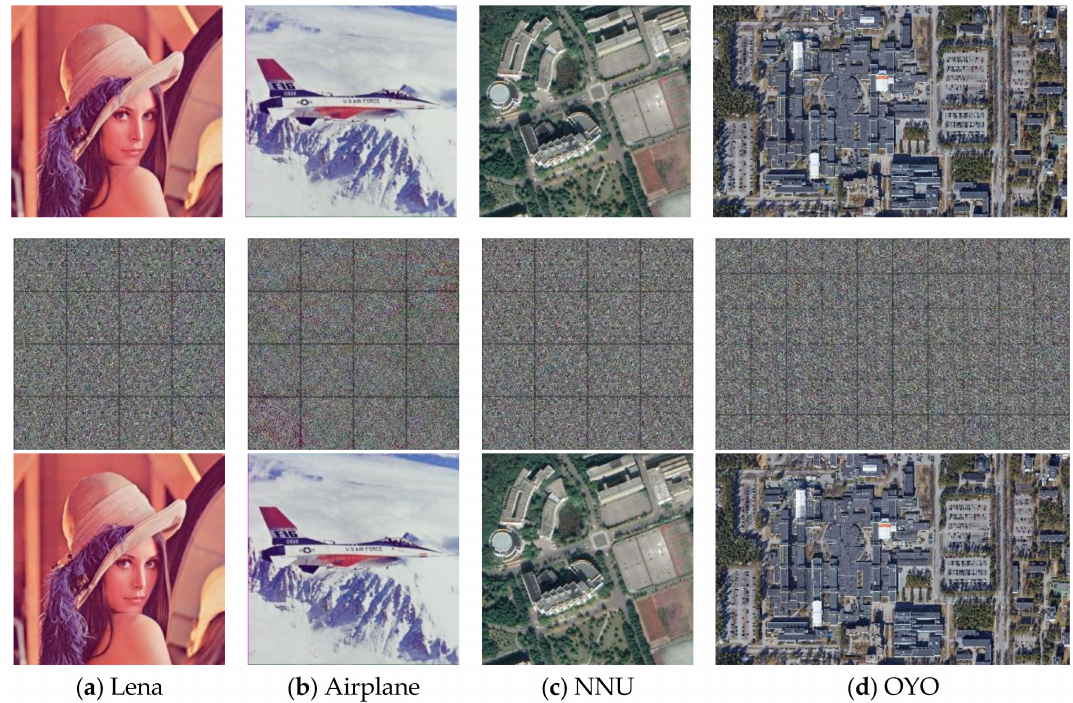
Figure 13. Examples of host images ( first row ), encrypted and watermarked images ( second row ), and decrypted and watermarked images ( third row ).